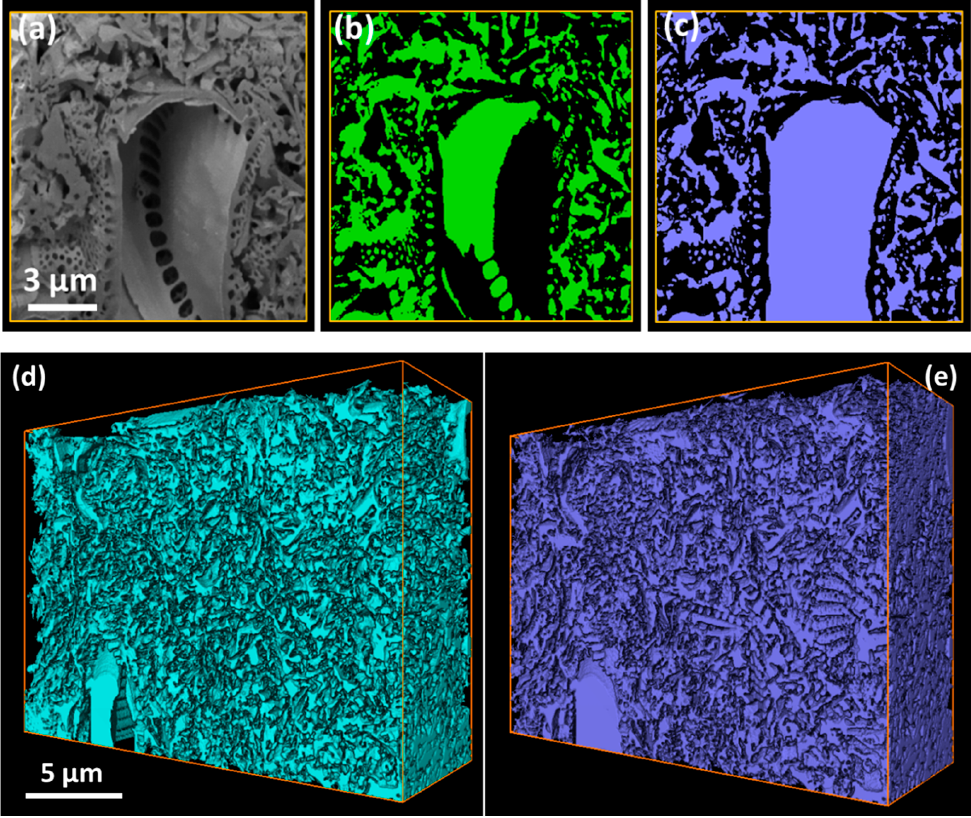
Figure 9. ( a ) A small region cropped from one slice image showing a big diatom with large pore space that extends in depth (along the Z direction); ( b ) the watershed segmentation result of this small slice image; ( c ) a thresholding plus manual correction result of the same region. Two different strategies for segmenting the pore space in the diatomite sample using Avizo: ( d ) watershed segmentation; ( e ) thresholding plus manual correction.